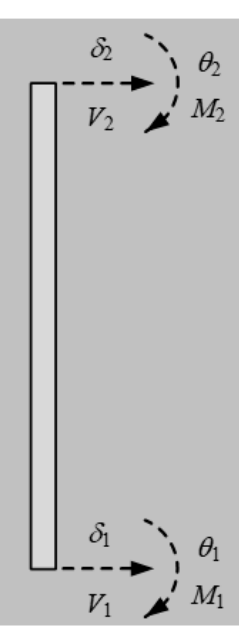
Figure 1. An axial-loaded beam–column with element-end displacements and forces.